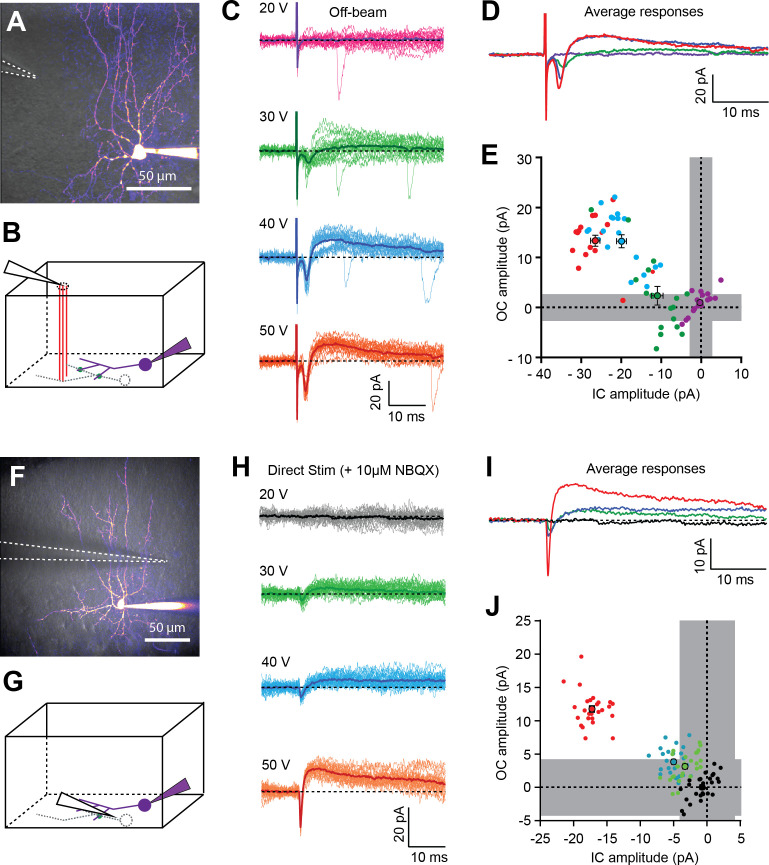
In the absence of direct excitatory transmission from PFs, GABAergic-independent outward currents are preceded by a short-lasting inward current.(A) 2PLSM image (maximal intensity projection) of a BC loaded with 20 µM Alexa-594. Dashed white lines indicate the position of the extracellular stimulation electrode on the surface of the slice (off-beam stimulation). (B) Schematic diagram of a parasagittal slice indicating off-beam stimulation of parallel fibers (PFs - red lines) synapsing onto the dendritic tree of an unpatched neighboring MLI (dashed gray lines), which forms putative electrical synapse(s) (green dots) with the patched cell (purple). (C) Postsynaptic current responses recorded in the patched cell in response to a single 50 µs voltage pulse at different stimulation intensities (20–50V). Dark lines represent averages of 15–30 single trials. (D) Superimposition of average responses from C, shown for visual comparison of the differences in mean peak amplitude of inward and outward currents. (E) Summary plot of peak amplitudes of inward and outward currents from individual trials shown in C, with corresponding averages +/- SEM represented by larger dots. gray regions represent 2*SD of baseline values (averaged over all traces). (F-J) Similar as in A-E, but spikelets were elicited by direct extracellular stimulation of a neighboring putative BC in the presence of 10 µM NBQX in the bathing solution to block AMPAR-mediated EPSCs. See also Figure 3—source data 1.